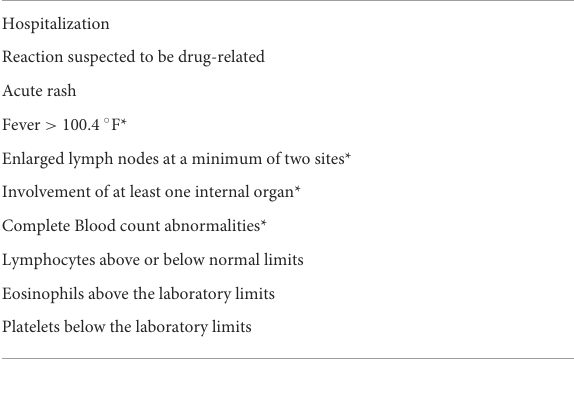
TABLE 1 Diagnostic criteria for potential drug reaction cases with eosinophilia and systemic symptoms (DRESS) published by the RegiSCAR